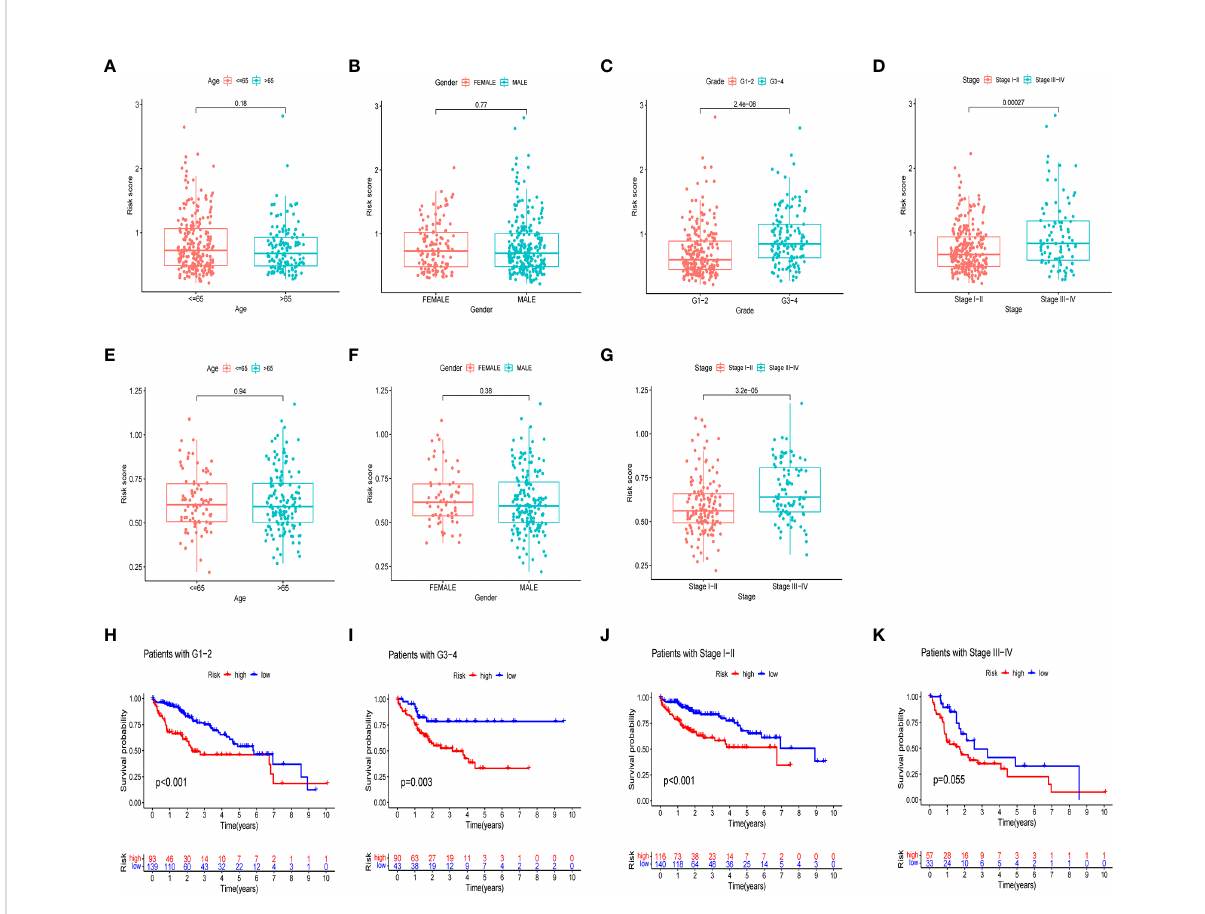
FIGURE 6 Risk scores and survival curves of different groups strati fi ed by clinical characteristics. TCGA cohort (A-D) , ICGC cohort (E-G) . (A, E) Age, (B, F) gender, (C) tumor grade, (D, G) tumor stage. (H) survival curves of Grade1-2. (I) survival curves of G3-4. (J) survival curves of stage I-II (K) survival curves of stage